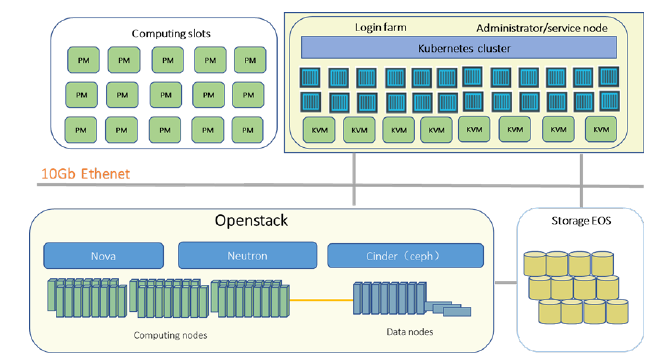
Figure 7. The architecture of HAASO Daocheng site